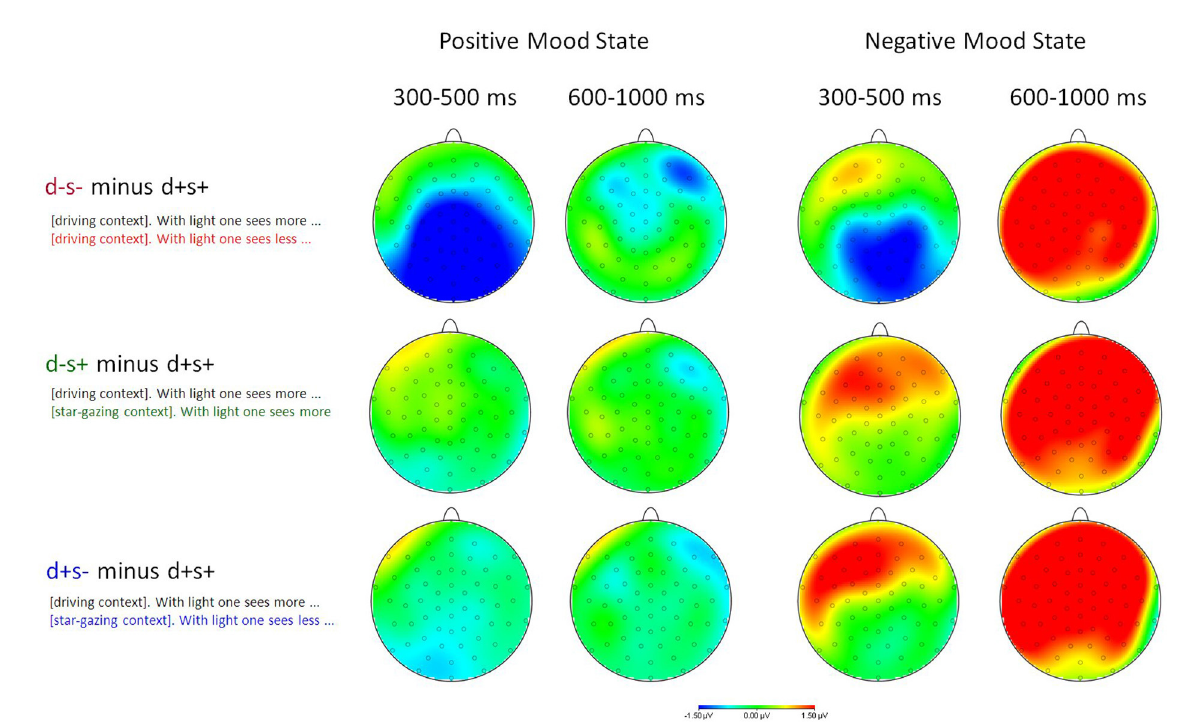
FIGURE4 Scalp distribution of the effects obtained by subtracting the supported critical word (d + s + ) from each of the other conditions (d-s-, d-s + , d + s-) in the N400 time window (300–500ms) and the LPC (late positivity component) time window (600–1,000ms).